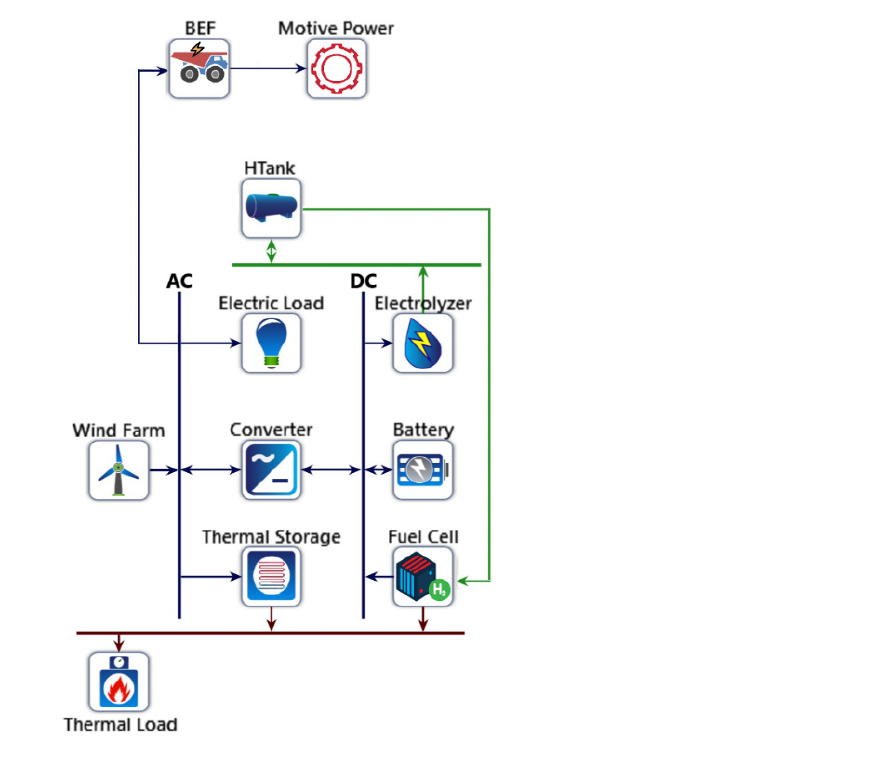
Figure 6. All-renewable system with battery electric fleet (BEF) and battery/fc storage configuration.